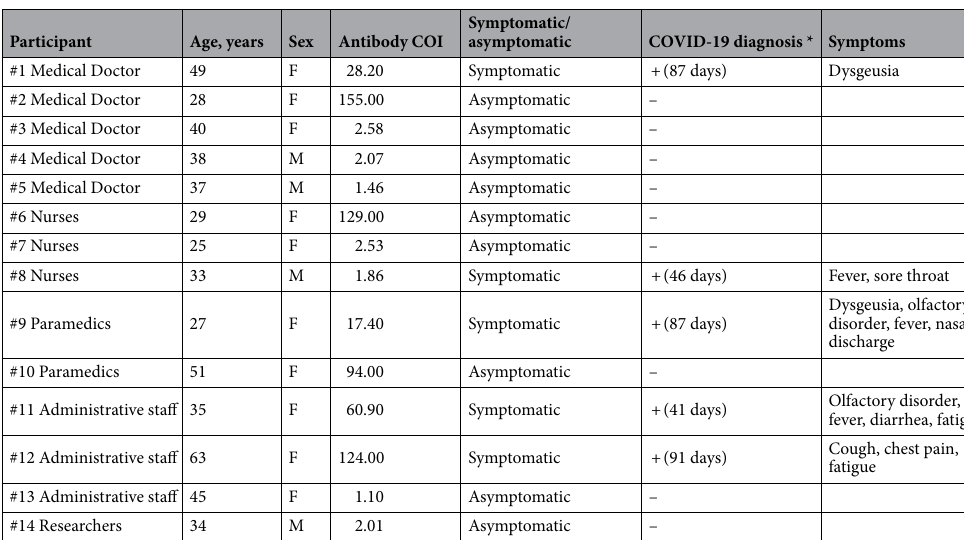
Table 3. Line listing of the clinical and demographic characteristics and the antibody levels of healthcare workers who tested positive for SARS-CoV-2 antibodies. *COVID-19 diagnosis was made using RT-PCR (days from diagnosis date to antibody detection date). COVID-19: coronavirus disease; SARS-CoV-2: severe acute respiratory syndrome coronavirus 2; RT-PCR: reverse transcription-polymerase chain reaction; M: male; F: female; COI: cutoff index.